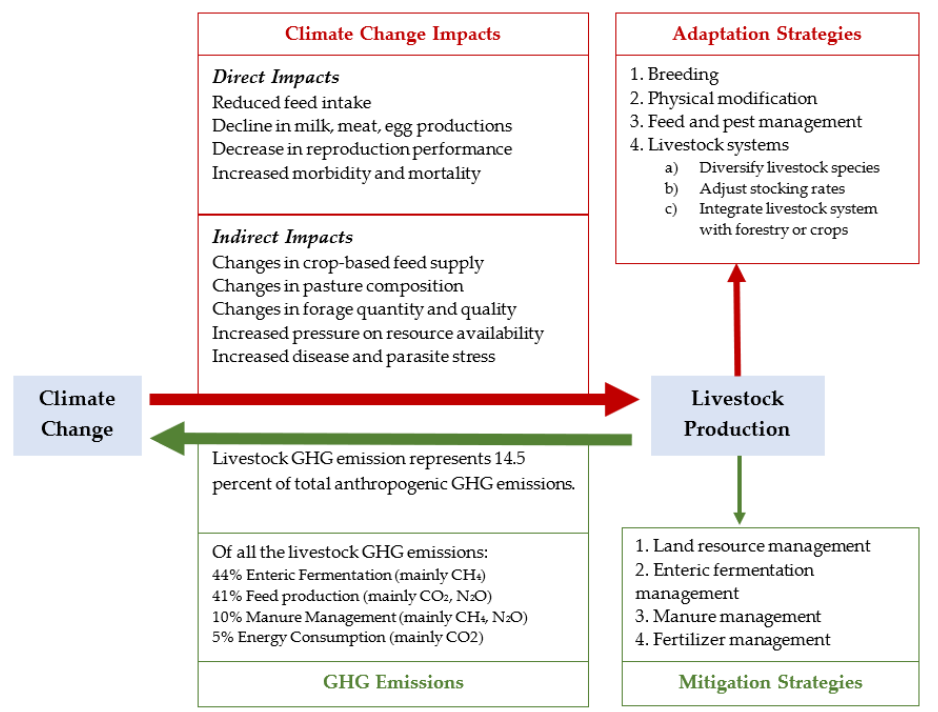
Figure 3. An overview of the relationship between climate change and livestock production.